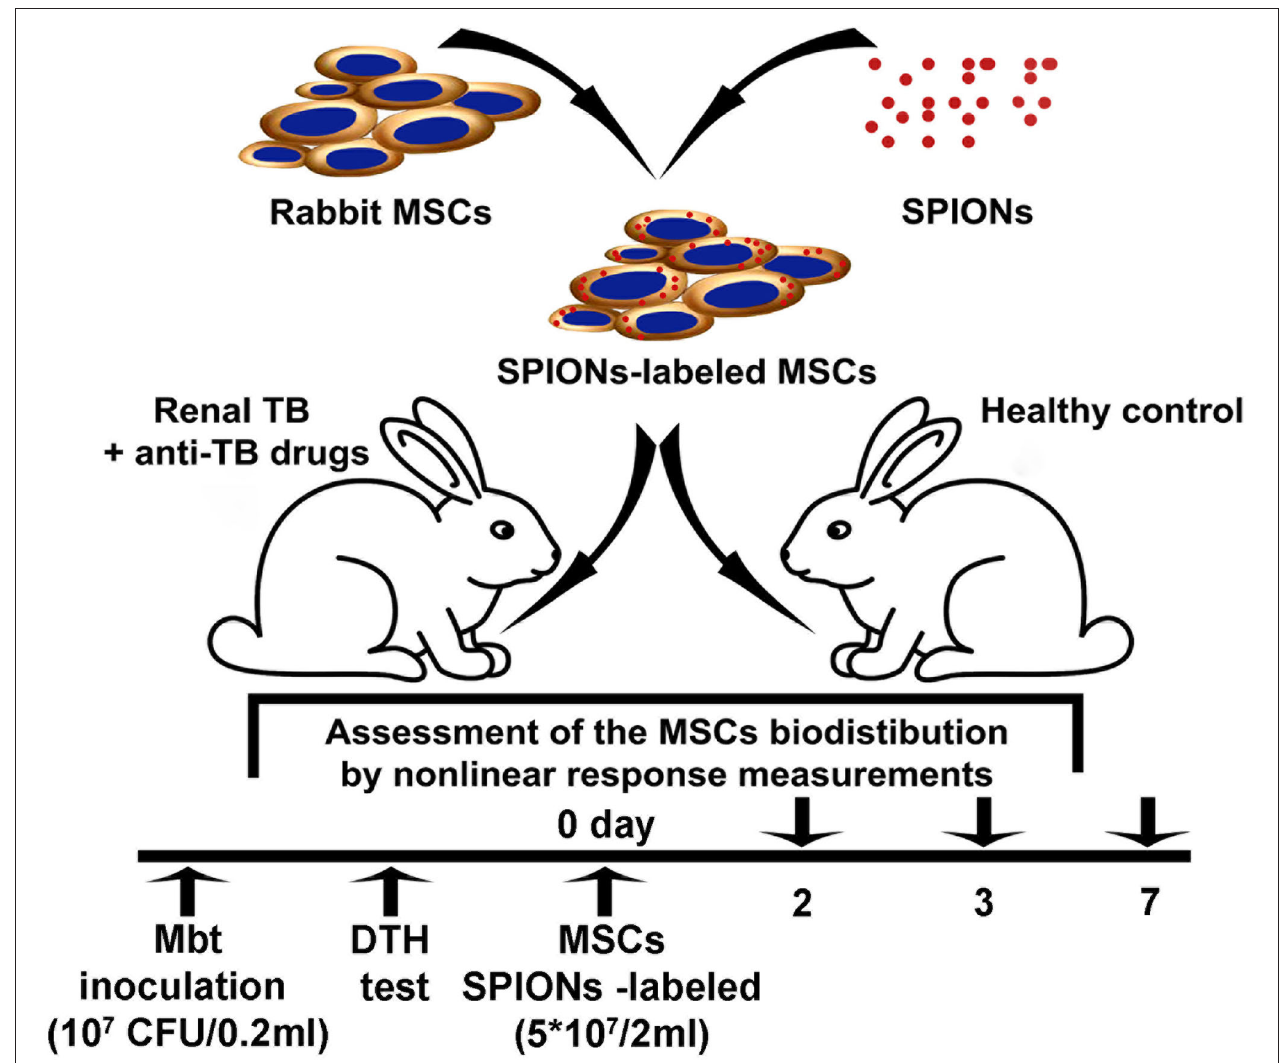
FIGURE 1 | Experimental study